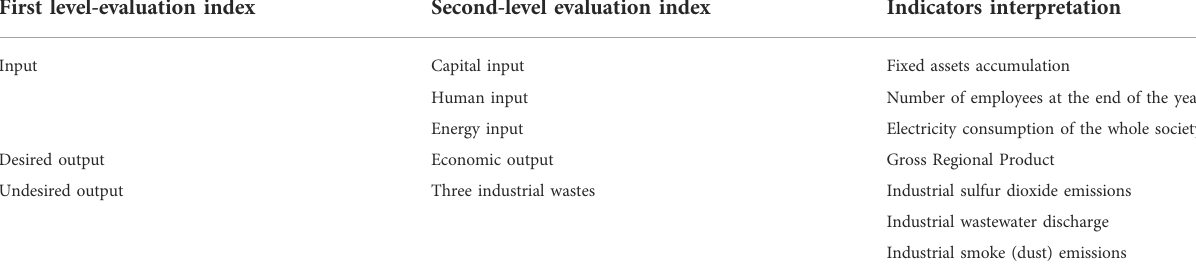
TABLE 1 Input-output indexes of environmental ef fi ciency and interpretation of the indexes. First level-evaluation index